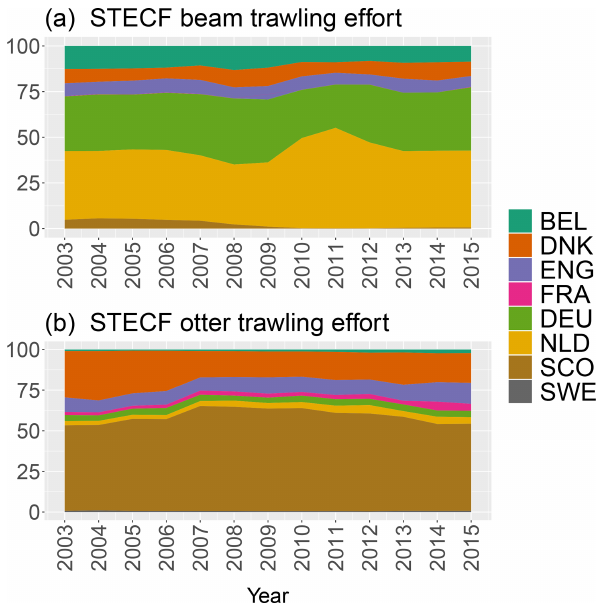
Figure 2. Percentage contribution of individual countries over time to (a) total beam trawl effort and (b) total otter trawl effort in the North Sea, based on the STECF